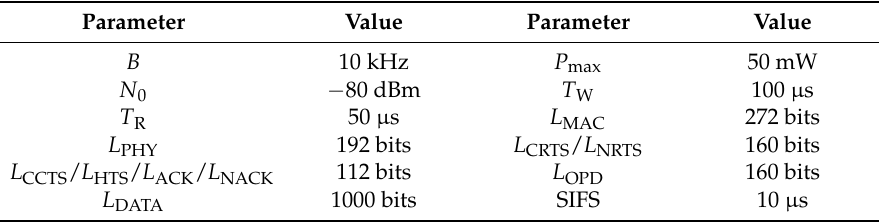
Figure 10. Number of data packets transmitted by each node with varying N at uniform traffic load. Figure 11. Network energy utilization with varying N at uniform traffic load.